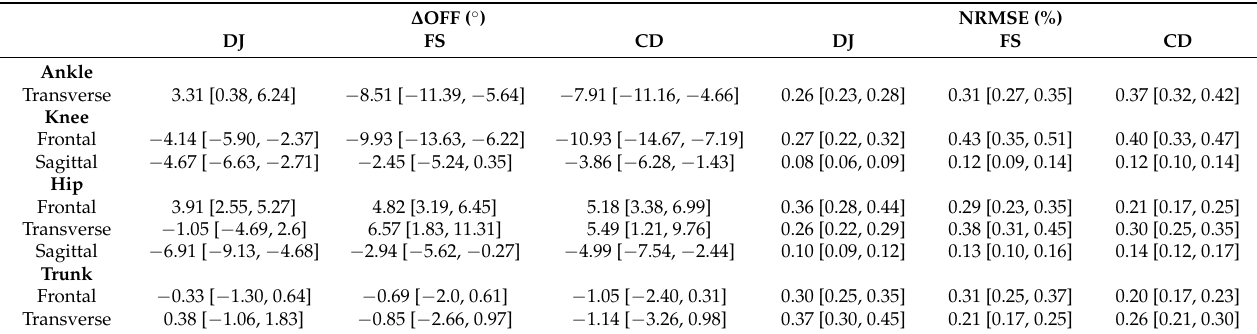
Table 3. Error measurements ( ∆ OFF, NRMSE) between the two motion capture systems for the three motor tasks, mean [range].